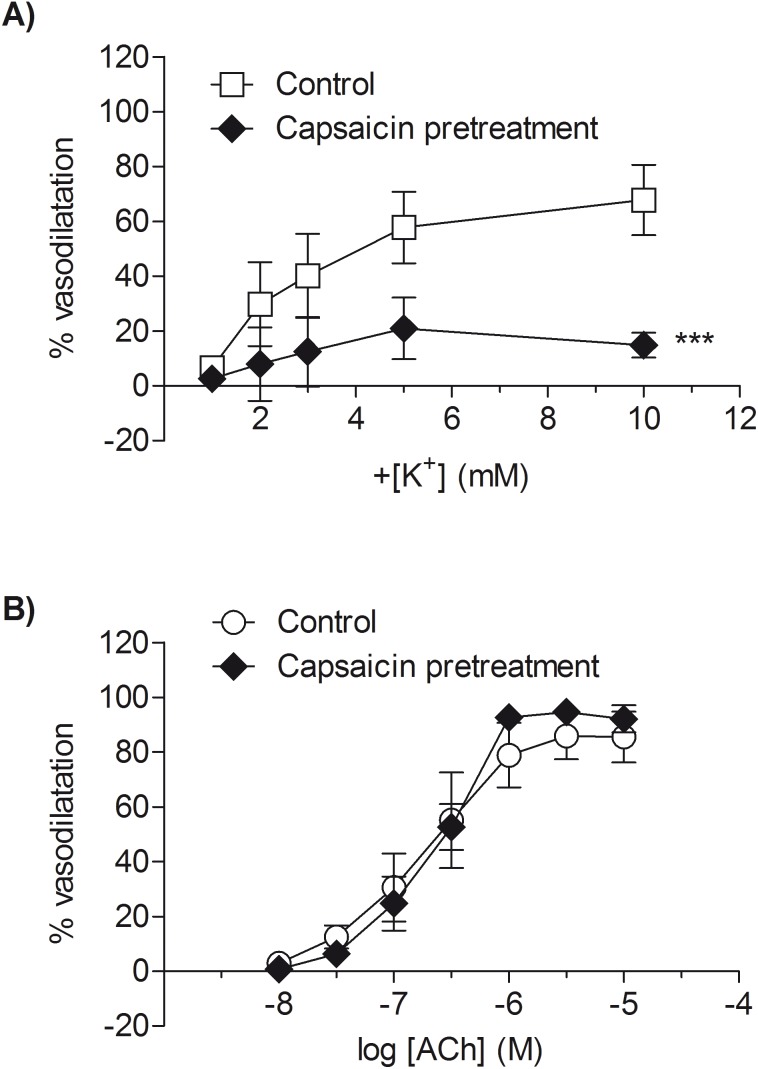
Responses to raised extracellular potassium, but not ACh, are capsaicin sensitive.The effect of capsaicin on responses to raised extracellular potassium (A) or ACh (B) in rat isolated mesenteric small arteries at 90 mmHg. All experiments were carried out presence of L-NAME (100 µM and indomethacin (1 µM). Each point represents the mean ± s.e.mean. ***P<0.001 capsaicin versus control; n = 4–5.